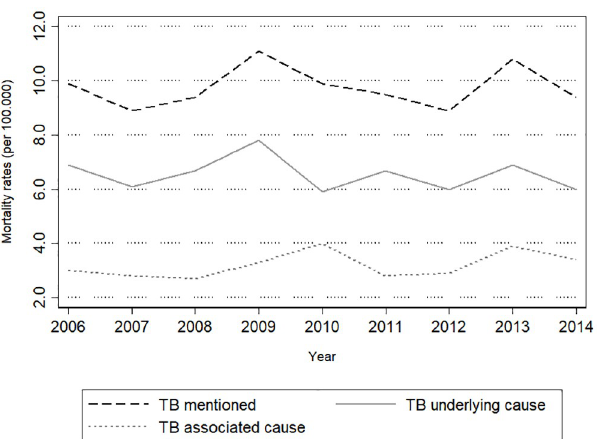
Fig 1. . Age adjusted � annual tuberculosis § mortality rates from 2006 to 2014, State of Amazonas, Brazil. � Direct standardization method and WHO 2000–2025 standard population [10]. § Reporting of tuberculosis on any part of the death certificate, corresponding to ICD10 codes A15-A19 (Tuberculosis block of three-character categories), B90 (Sequelae of tuberculosis three-character category) and B20.0 (HIV resulting in mycobacterial infection four-character subcategory)—International Statistical Classification of Diseases and Related Health Problems 10th Revision [8]. TB reported: Tuberculosis reported as underlying or associated cause of death; TBUC: Tuberculosis reported as the underlying cause of death; TBAC: tuberculosis reported as an associated cause of